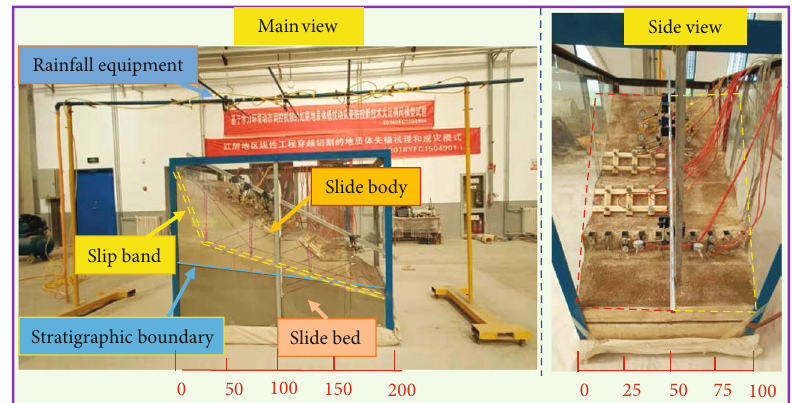
Figure 5: Complete physical model diagram before the test (the unit of dimension in the fi gure is